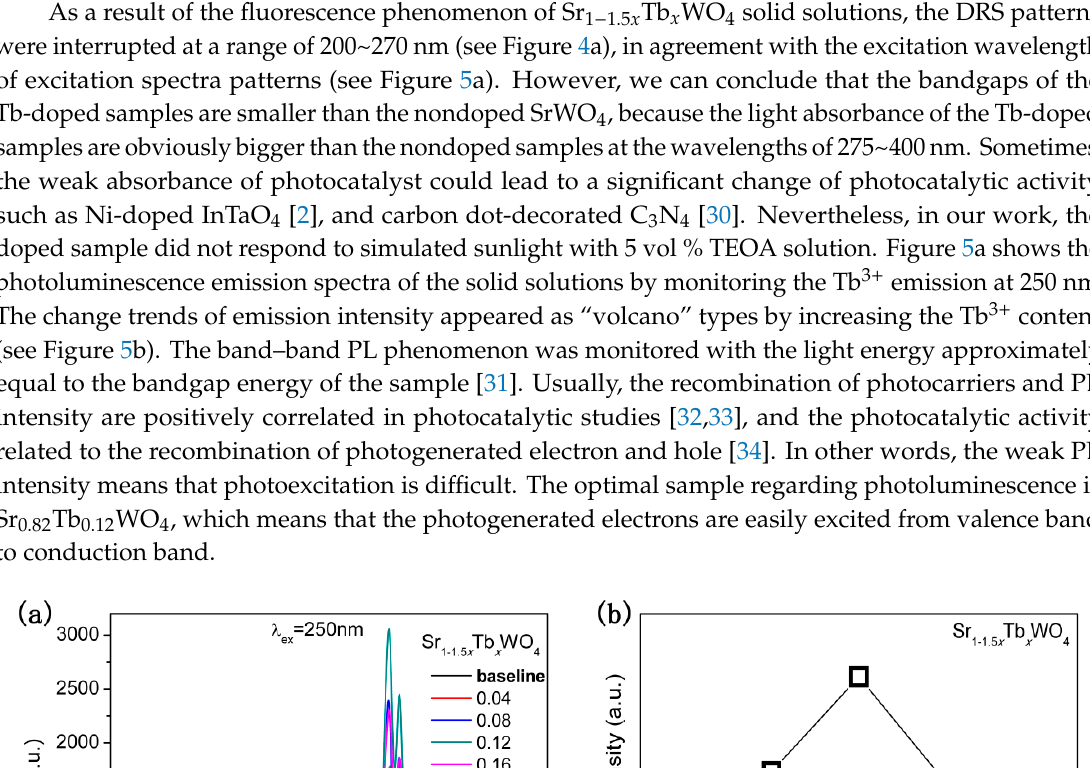
Figure 4. ( a ) UV–vis diffuse reflectance spectrum for Sr 1 − 1.5 x Tb x WO 4 solid solutions. ( b ) Estimated bandgap energy E g with plot of ( α h ν ) 2 against photon energy ( h ν ) for SrWO 4 .